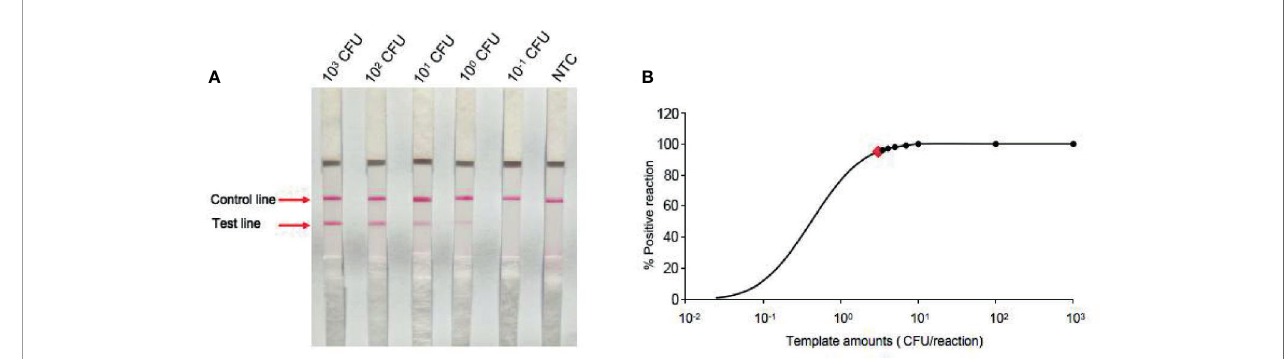
FIGURE 4 | Determination of limit of detection (LOD) of P. aeruginosa RPA-LFS assay. (A) The LOD of the established RPA-LFS detection system for P. aeruginosa was determined from eight independent assays using genomic DNA from P. aeruginosa in a serial dilution ranging from 10 -1 to 10 3 CFU per reaction. Images were the RPA-LFS results and template amounts are indicated on the top of the strips. (B) Probit regression analysis using SPSS software was conducted on data collected from eight repeats.